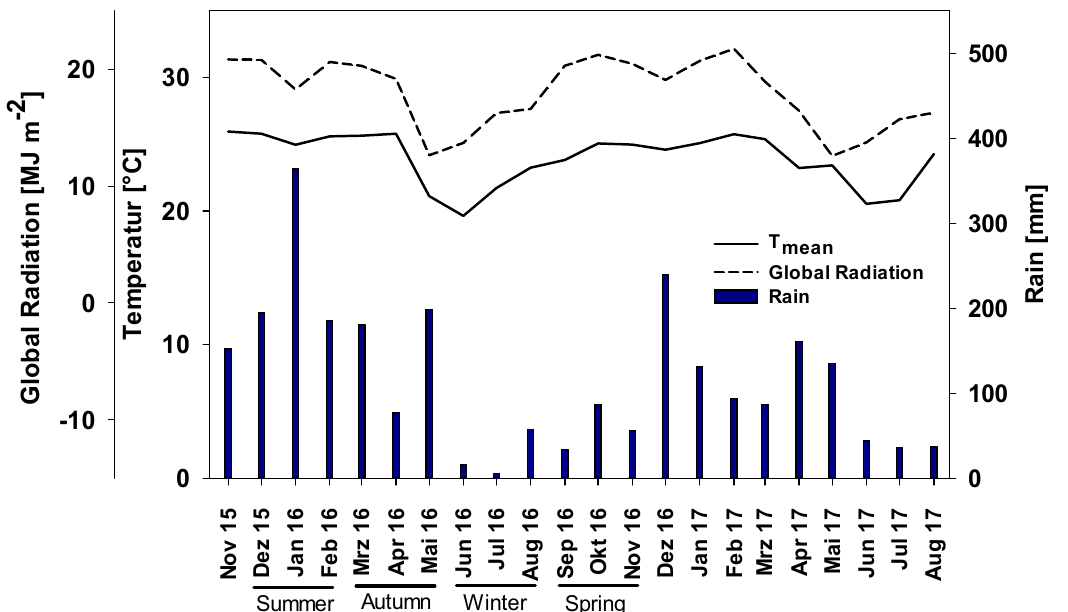
Figure 1. Monthly mean global radiation (MJ m − 2 ), temperature ( ◦ C) and cumulative monthly rain (mm) from November 2015 until August 2017. Cumulative rain for year 1 (15 November–16 October) 1553 mm and for year 2 (16 November–17 August) 1020 mm.